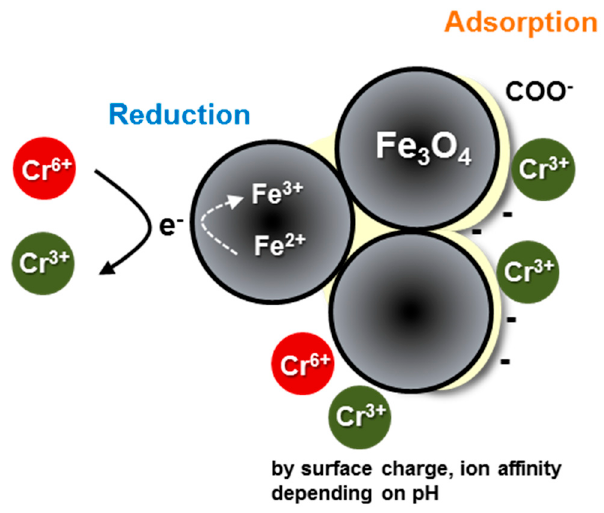
Figure 6. Schematic illustration of the mechanism of Cr(III/VI) removal by biogenic magnetite nanoparticles.